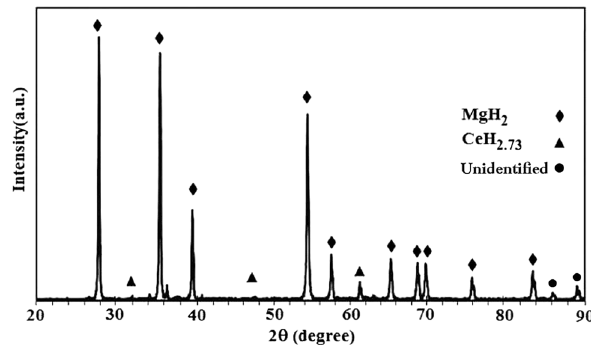
Fig. 7 The XRD pattern of 30 min ball-milled MgH